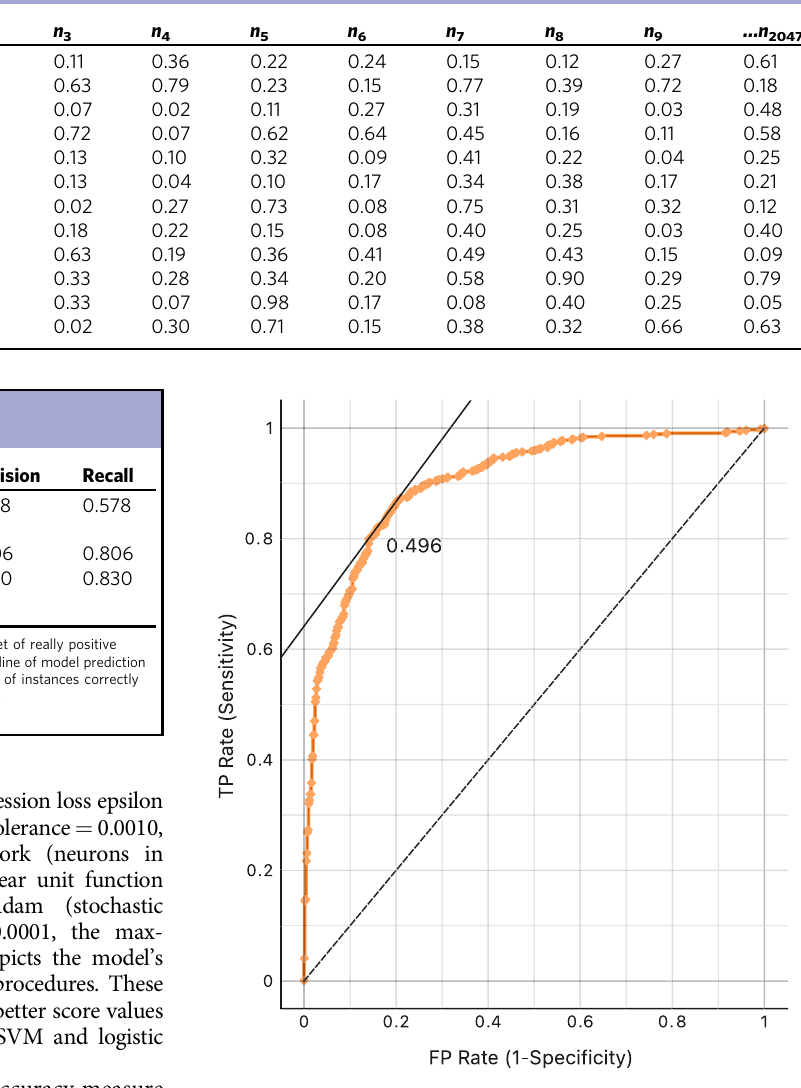
Fig. 2 Multilayer perceptron neural (MLP) network ROC curve. ROC curve stands for receiver operating characteristic curve. It depicts a compromise between classi fi er model sensitivity (TP (true positive) rate on the graph) and classi fi er model speci fi city (FP (false positive) rate on the diagram). Classi fi ers returning the ROC curves closer to the top-left corner (TP rate is near its maximum of 1) exhibit better model performance.